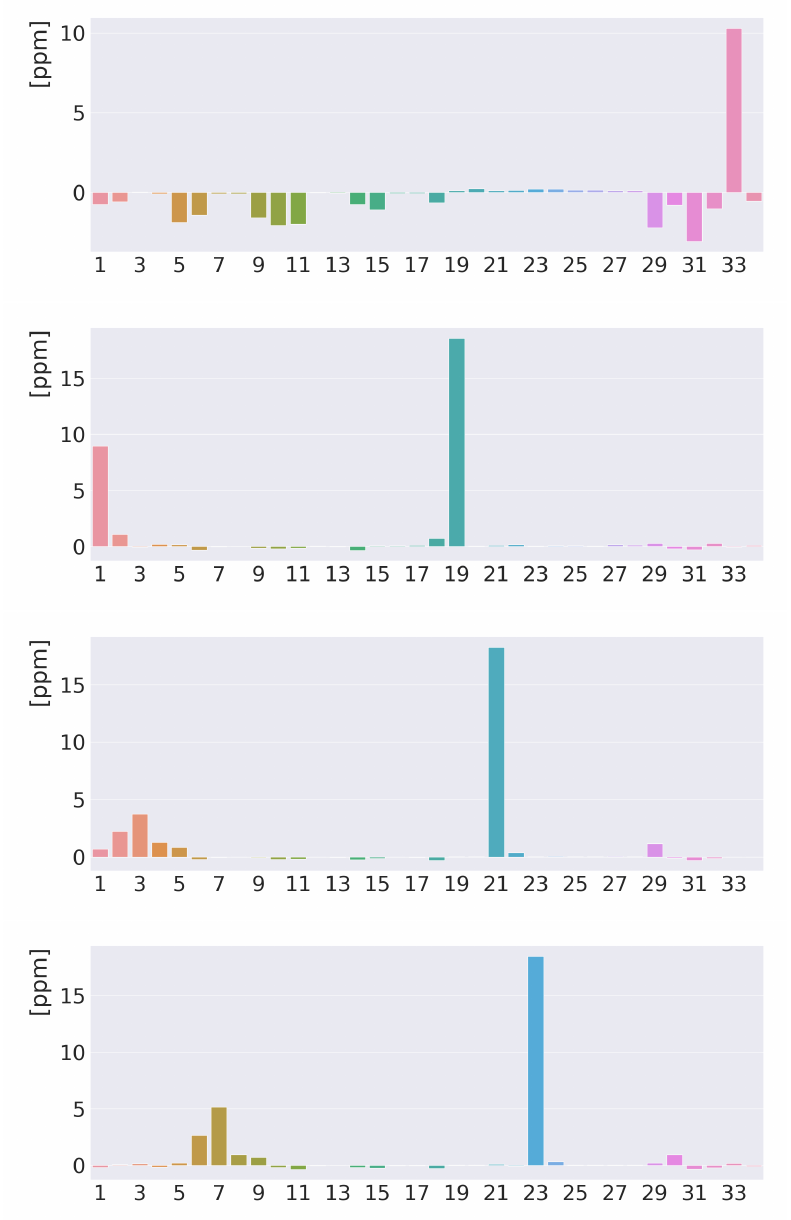
Figure 11. Atomic contributions (in ppm) to the isotropic 1 H NMR shielding constants of free-base trans -norcorrole. From above: the inner hydrogen, the meso hydrogen, the β hydrogen atoms of the pyrrole ring with an inner hydrogen, and the β hydrogen atoms of the pyrrole ring without an inner hydrogen. The atoms are numbered along the x axis in the same order as in